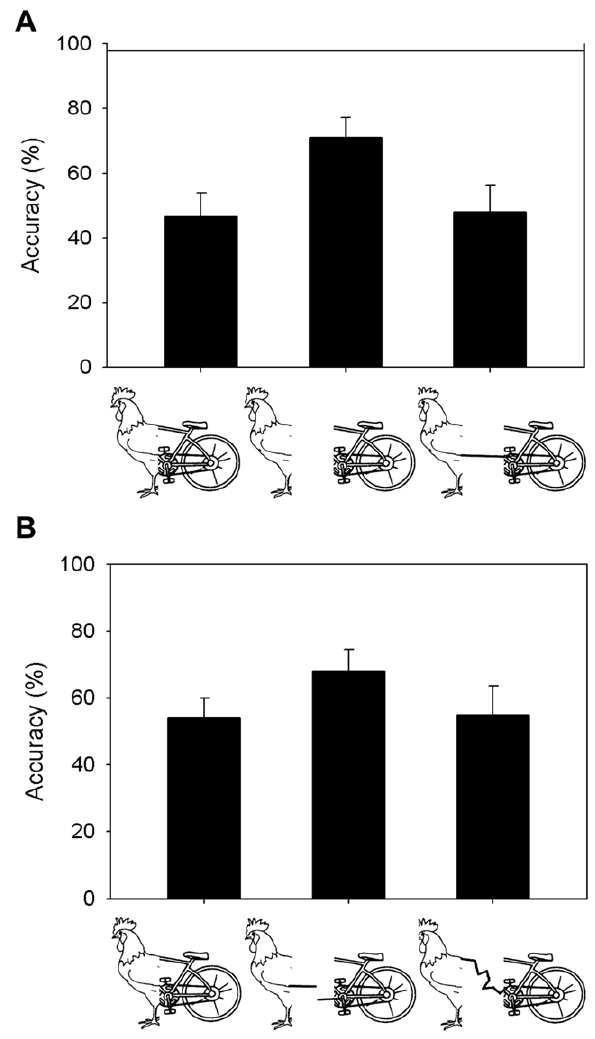
Figure 2. Proportion of correct identifications of the left side of the figures under the conditions of Chimeric, Chimeric-Gap, and Chimeric-Connected. (A) Experiment 1, spatial separation for Chimeric-Gap condition and connection by a line segment for Chimeric- Connected condition. (B) Experiment 2, a broken line in the gap for Chimeric-Gap condition and connection by a random curve for Chimeric-Connected condition. The error bars show the stand errors of the